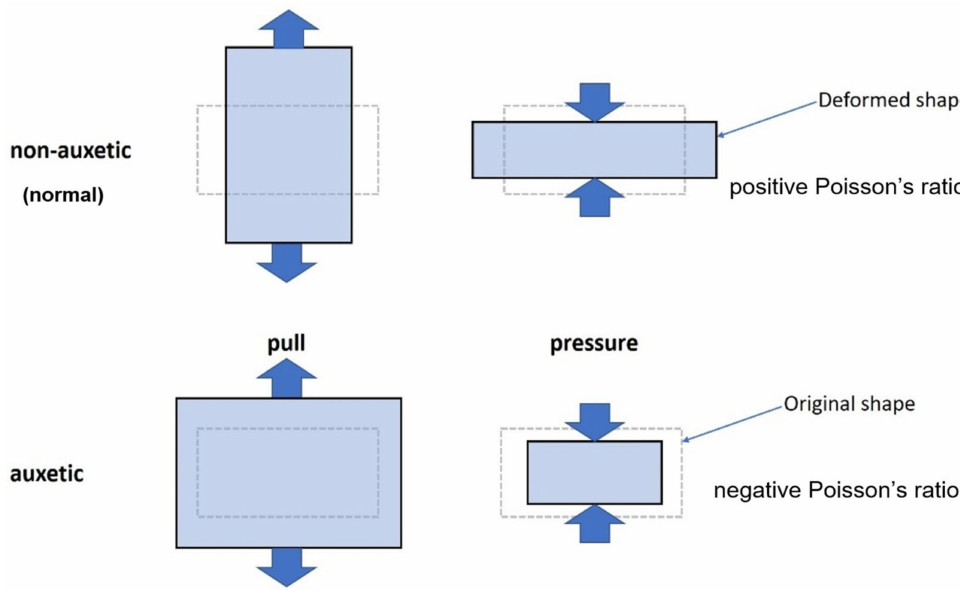
Figure 1. Comparison of conventional (positive Poisson’s ratio) and auxetic (negative Poisson’s ratio) deformation behavior.